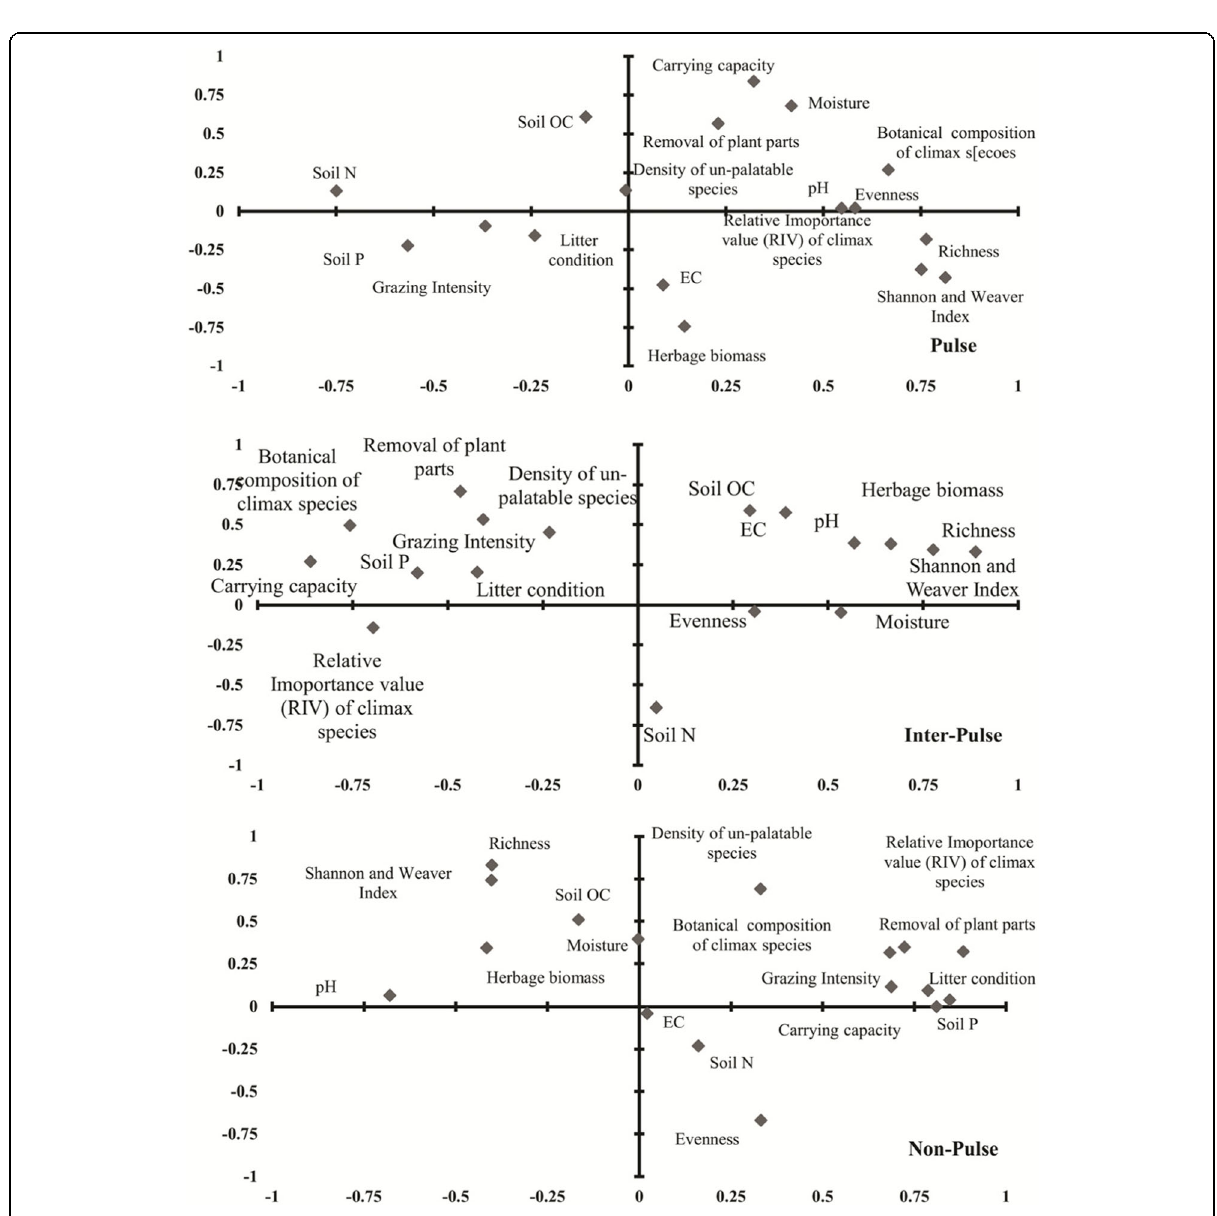
Fig. 1 Principal component analysis for variables used for weighting factors during different pulse